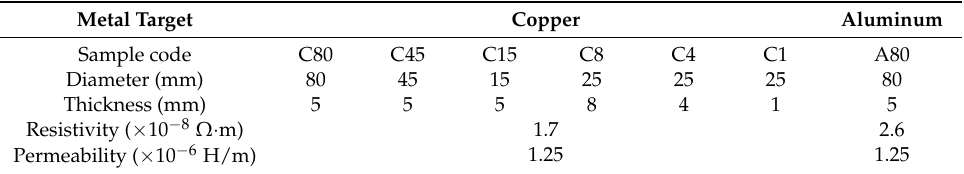
Table 2. Details of the metal targets used in this